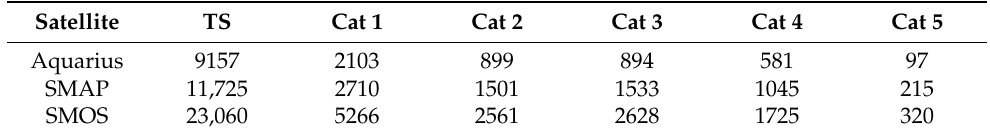
Table 1. TC track position counts for each TC intensity category. The IBTrACS data from August 2011 (SMOS) are